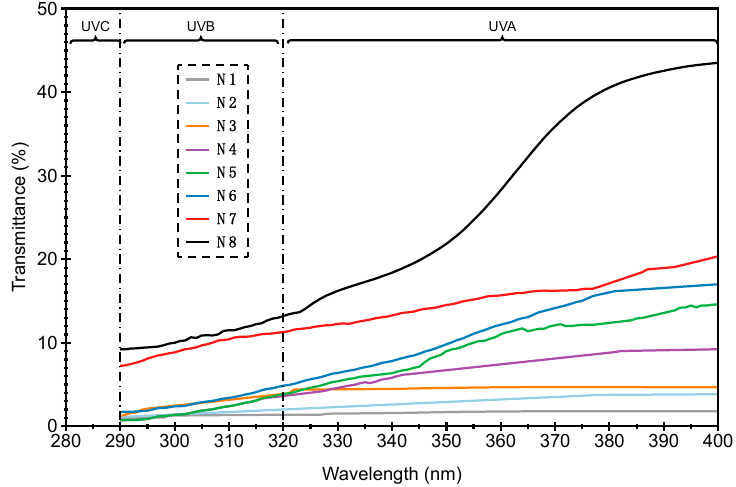
Figure 9. UV transmittance of Cu/Ni-coated Milife fabric over 290–400 nm (UVA and UVB).